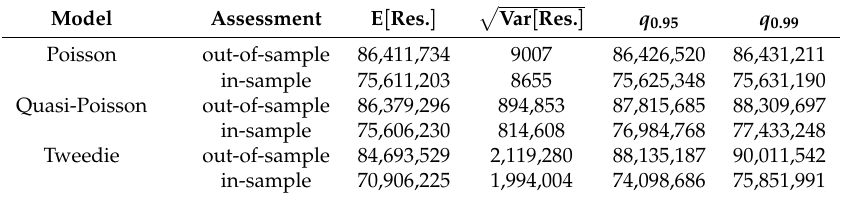
Table 5. Prediction results (RBNS) for individual generalized linear models using covariates.